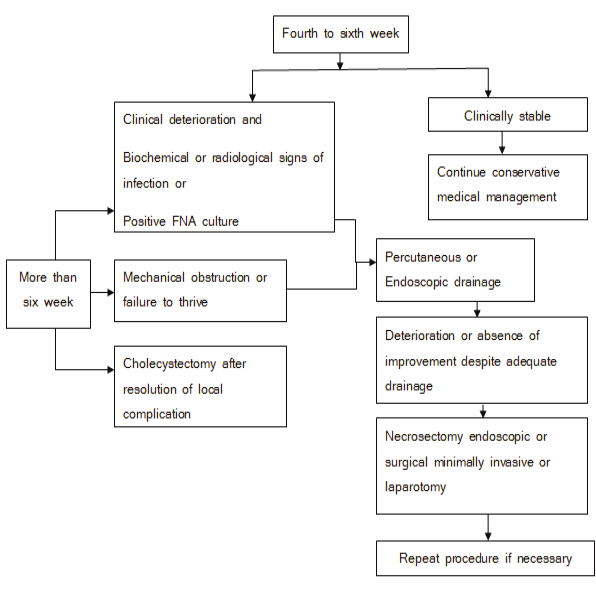
Figure 2 : Algorithm showing a step-up approach from fourth week onwards (cid:39)(cid:72)(cid:80)(cid:82)(cid:74)(cid:85)(cid:68)(cid:83)(cid:75)(cid:92)(cid:3)(cid:68)(cid:81)(cid:71)(cid:3)(cid:73)(cid:85)(cid:72)(cid:84)(cid:88)(cid:72)(cid:81)(cid:70)(cid:92)(cid:3)(cid:90)(cid:72)(cid:85)(cid:72)(cid:3)(cid:68)(cid:81)(cid:68)(cid:79)(cid:92)(cid:93)(cid:72)(cid:71)(cid:3)(cid:88)(cid:86)(cid:76)(cid:81)(cid:74)(cid:3)(cid:54)(cid:87)(cid:68)(cid:87)(cid:76)(cid:86)(cid:87)(cid:76)(cid:70)(cid:68)(cid:79)(cid:3) Package for the Social Sciences (SPSS) version 22. The outcome of the step-up approach was assessed using the patient’s recovery and follow up status.